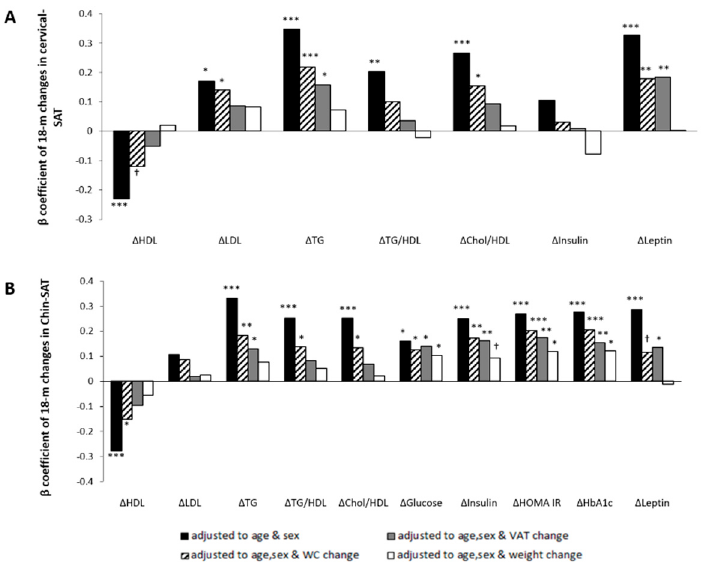
Figure 5. Associations between 18-month changes in cervical and chin SATs and changes of blood biomarkers; multivariate linear regression models. Panel ( A ) and panel ( B ) show cervical-SAT and chin-SAT dynamics associations, respectively. Models were adjusted for age and sex (black bar); age, sex and WC change (black with white strips bar); age, sex, and VAT change (grey bar); and age, sex, and weight change (white bar). Statistical significance: *** p ≤ 0.001; ** p ≤ 0.01; * p ≤ 0.05; † p ≤ 0.1. WC, Waist circumference; VAT, visceral adipose tissue; HDL-c, high-density lipoprotein cho- lesterol; LDL-c, low-density lipoprotein cholesterol; TG, triglycerides; HOMA, homeostasis model assessment; IR, insulin resistance; HbA1c, glycated hemoglobin.